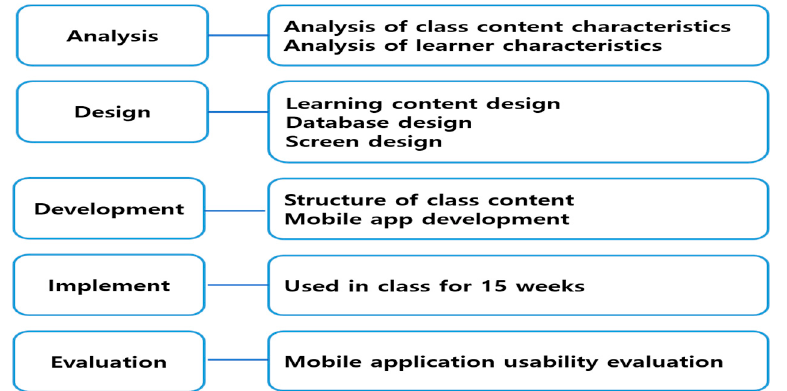
Figure 1. ADDIE (Analysis, Design, Development, Implement and Evaluation) model.